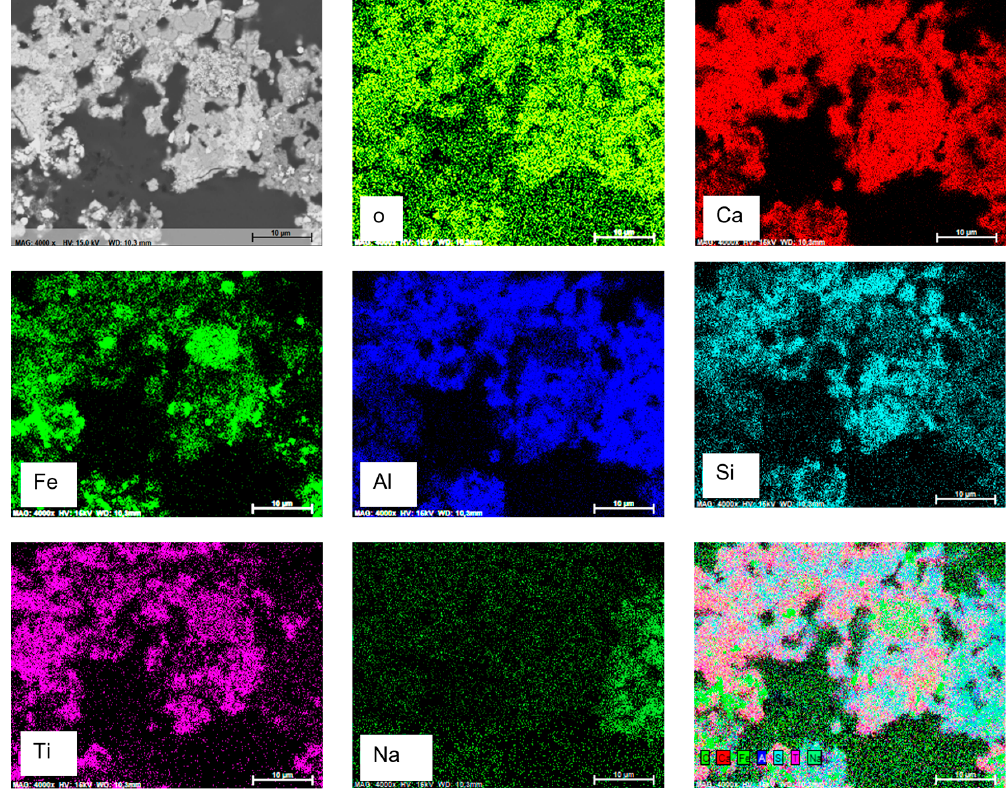
Figure 12. SEM image and EDS analysis of reduced sample RH3.